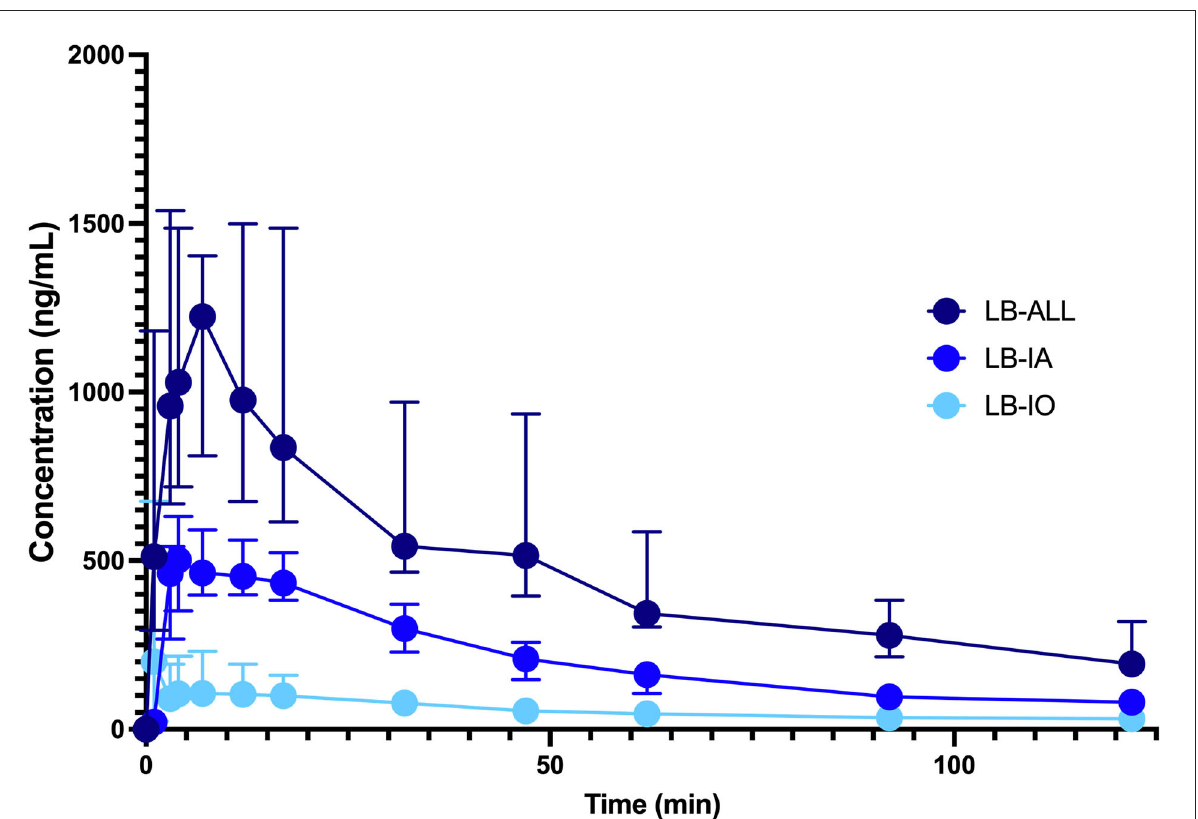
FIGURE1 Concentration-vs.-time profile of LB 0.5% injected perineurally as a single infraorbital block ( (cid:8) , n = 10, LB IO) or single inferior alveolar block ( (cid:8) , n = 10, LB IA group) or both infraorbital and inferior alveolar blocks ( (cid:8) , n = 10, LB ALL group). Dogs were premedicated with methadone intravenously, and anesthesia was induced with propofol and maintained with isoflurane in oxygen. The dose of LB was calculated as 0.11 ml/kg 2 / 3 for the infraorbital block and 0.18 ml/kg 2 / 3 for the IA block. The data are presented as median with interquartile